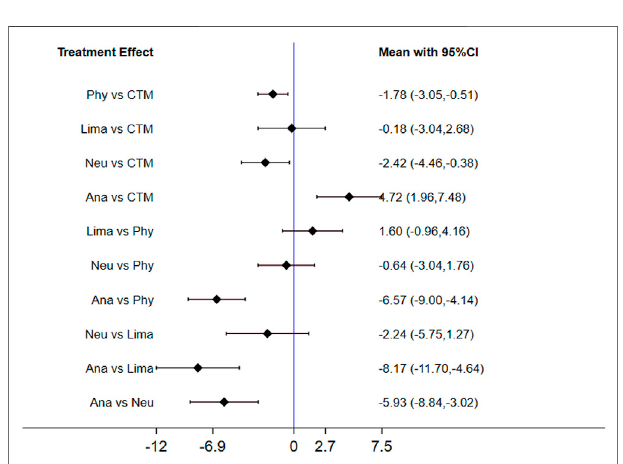
FIGURE 7 | Mean difference for JOA between treatments.